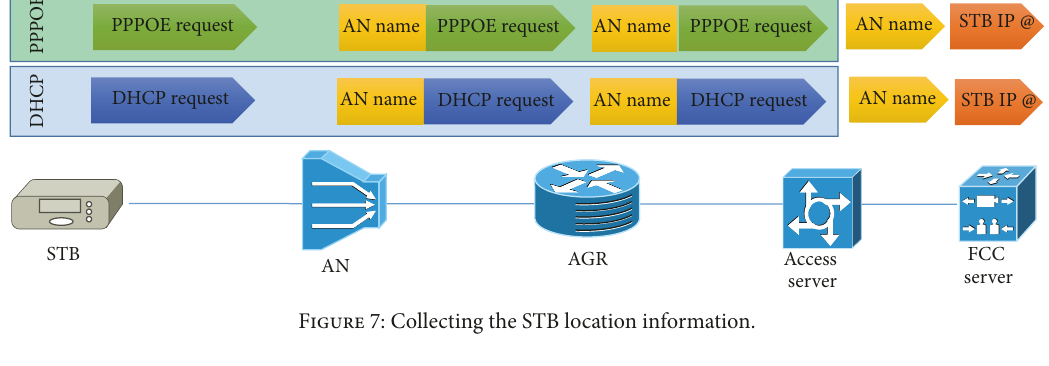
Figure 7: Collecting the STB location information.